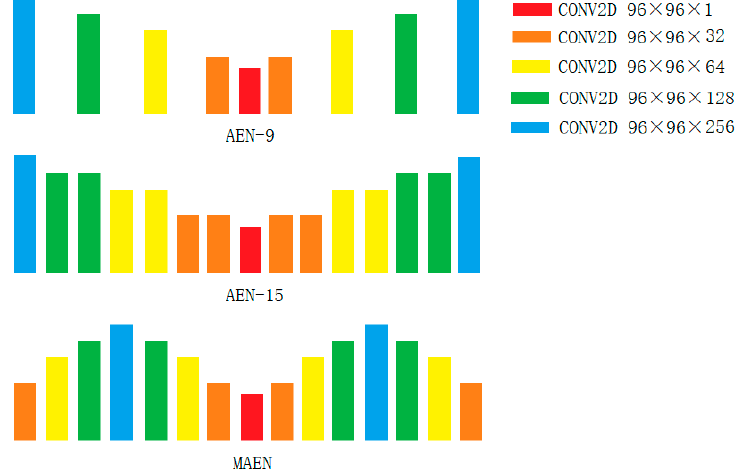
Figure 7. The proposed MAEN structure and comparison with the normal AEN structure (AEN-9,